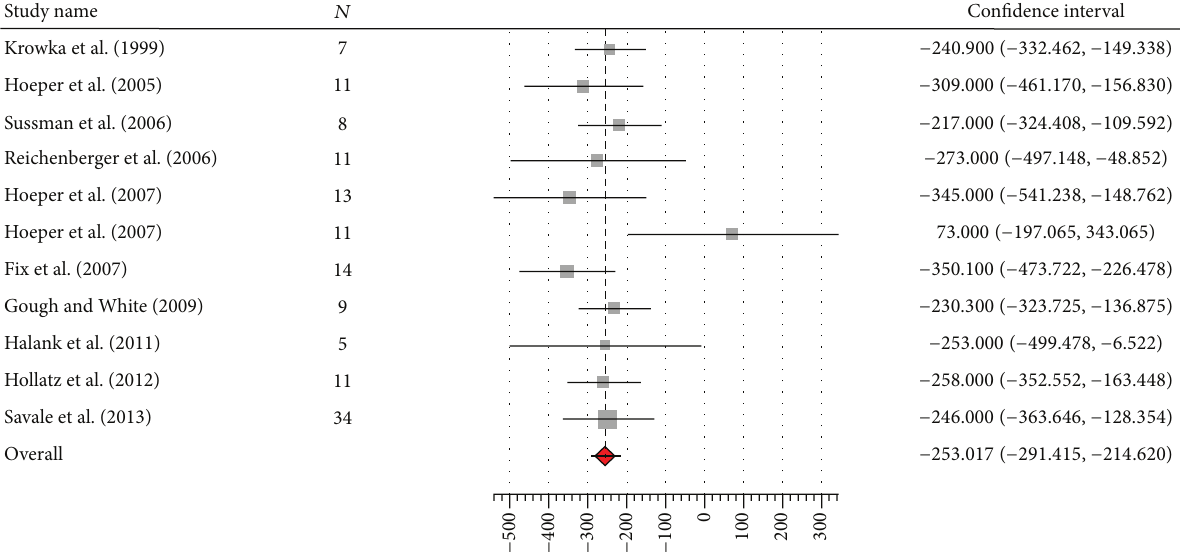
Forest plot: 95% confidence interval